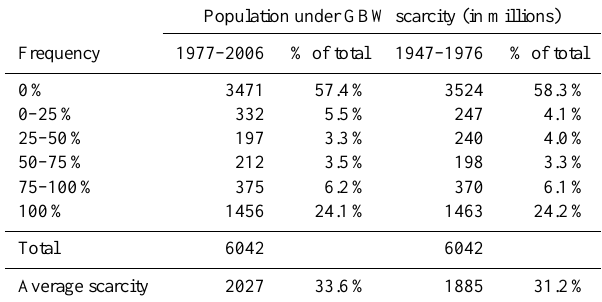
Table 1. Global population (in millions) under green-blue wa- ter (GBW) scarcity. Frequency of scarcity over the climatic pe- riod of 1977–2006 and over the 30yr climatic period before that (1947–1976). Bottom row (“average scarcity”) represents the GBW scarcity under average climate conditions within those climatic pe- riods. See also Figs. 2 and 4e. Note that the calculations were made for constant reference population and agronomical practices (year 2000 situation) but varying climate within the indicated time periods.